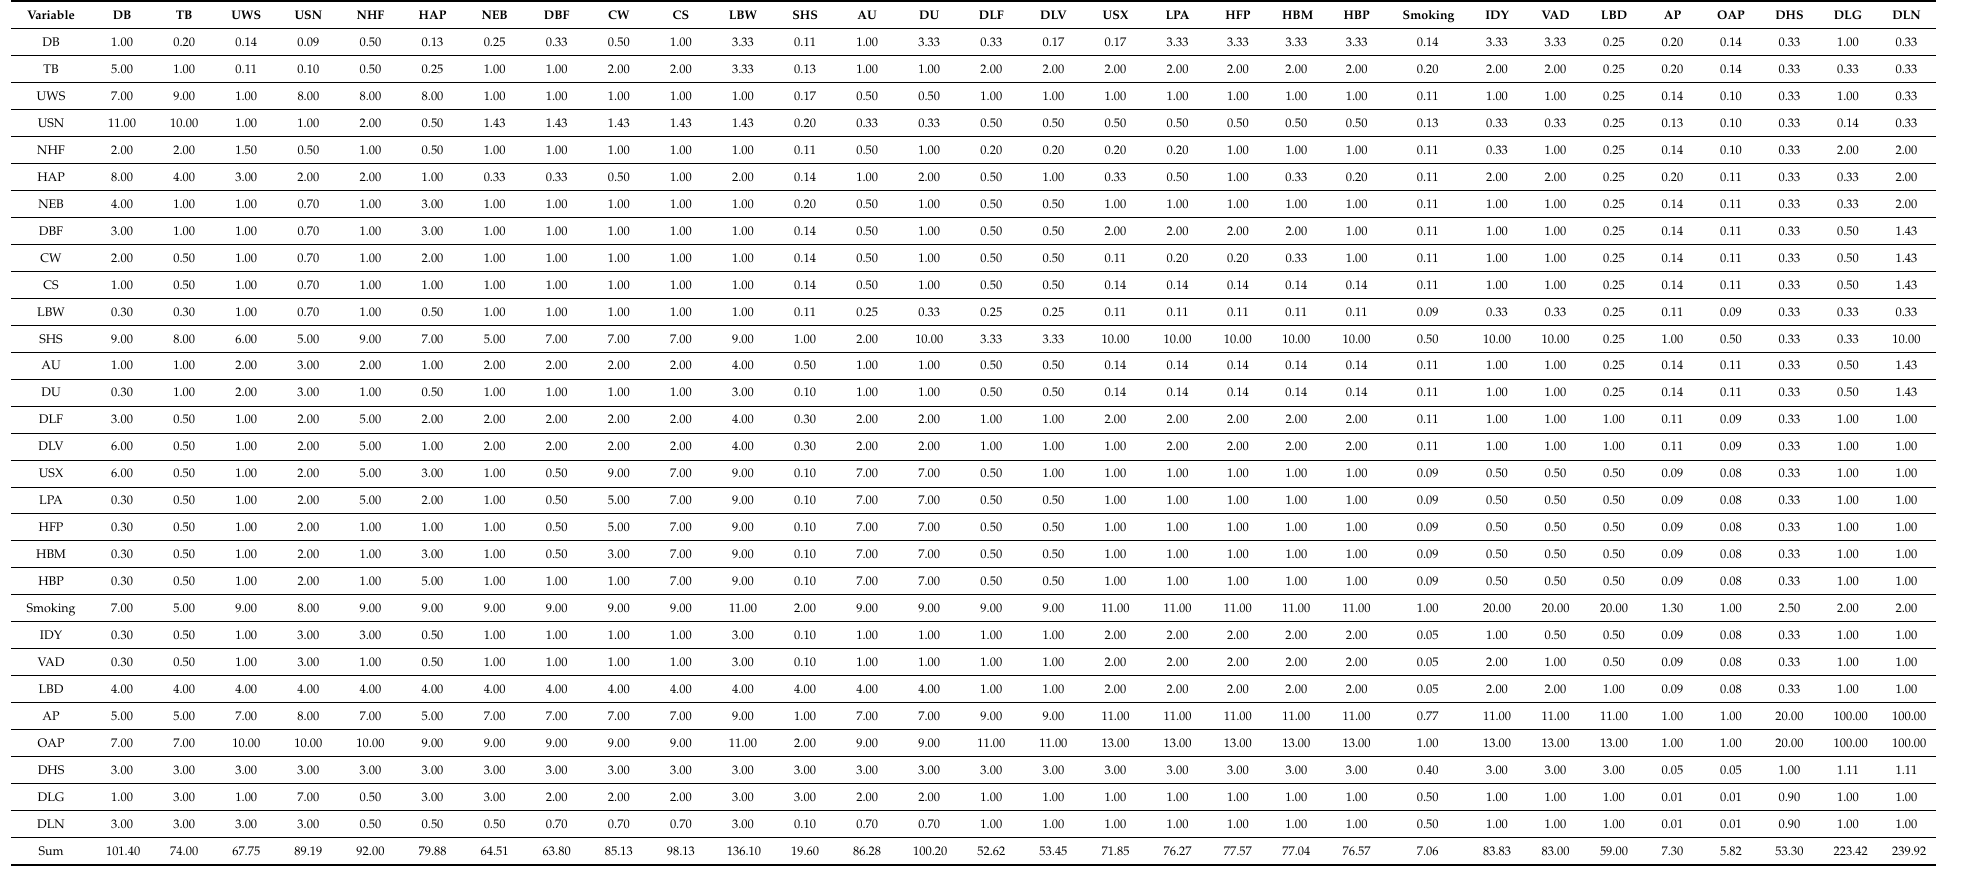
Table 6. Results of the Delphi